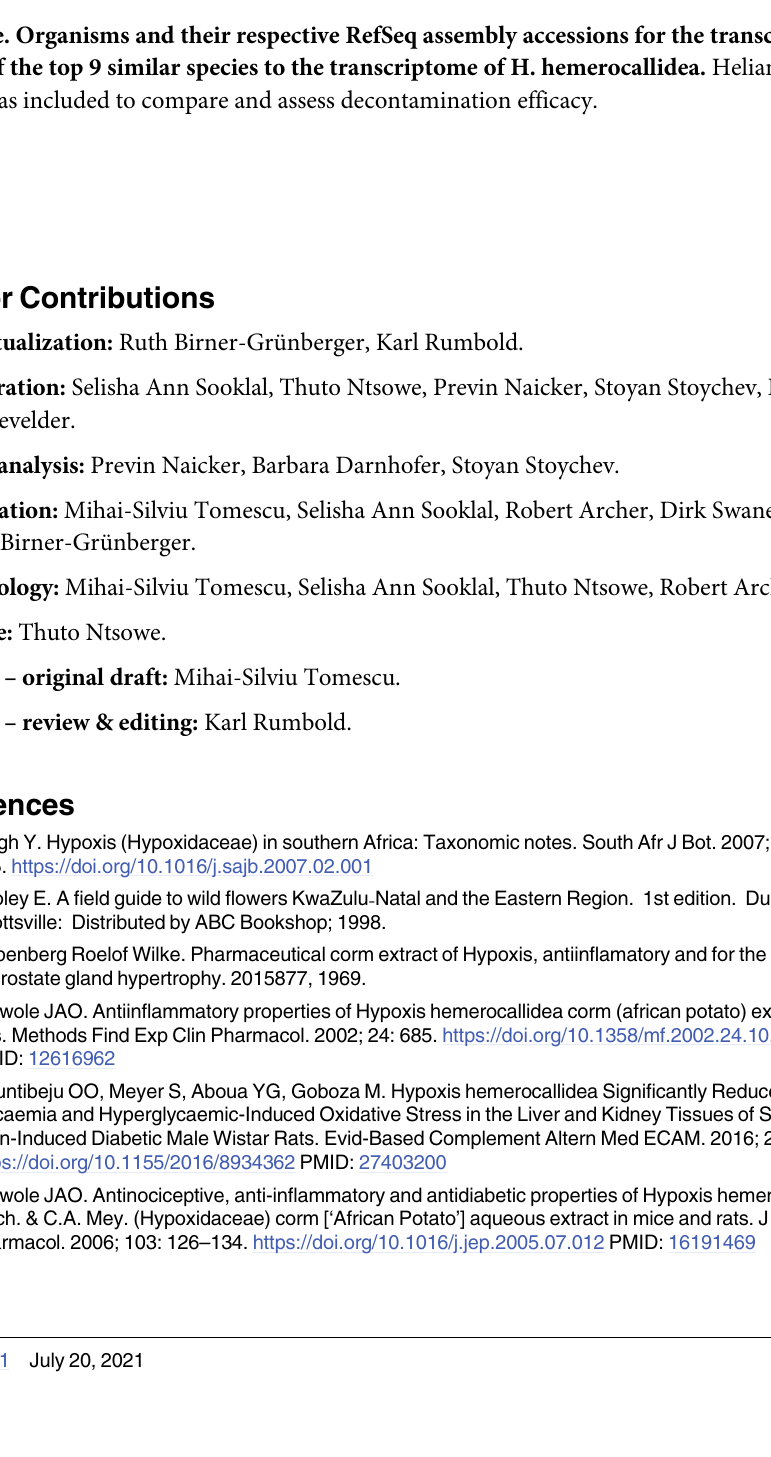
S14 Fig. Gene ontology molecular function annotation of transcripts with terpene synthase activity. Yellow–terpene synthases that although annotated by nr, Mercator4 and GO, func- tion could +only be retrieved from GO annotation. Grey–nr annotated terpene synthases attributed with multiple terpene synthase activity by GO. Brown–GO terpene synthase activity corresponding to the terpene synthases mapped by Mercator 4 and nr. Light blue–terpene synthases annotated by Go and nr but not Mecator4. S1 Table. Name of organisms and respective RefSeq assembly accessions of genomes used with DeconSeq to retain contaminants H . hemerocallidea . S2 Table. Organisms and their respective RefSeq assembly accessions for the transcrip- tomes of the top 9 similar species to the transcriptome of H. hemerocallidea. Helianthuus anuus was included to compare and assess decontamination